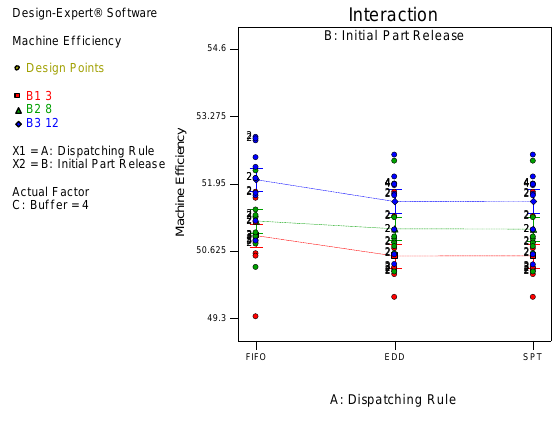
Figure 13. Machine efficiency initial part release & dispatching rule